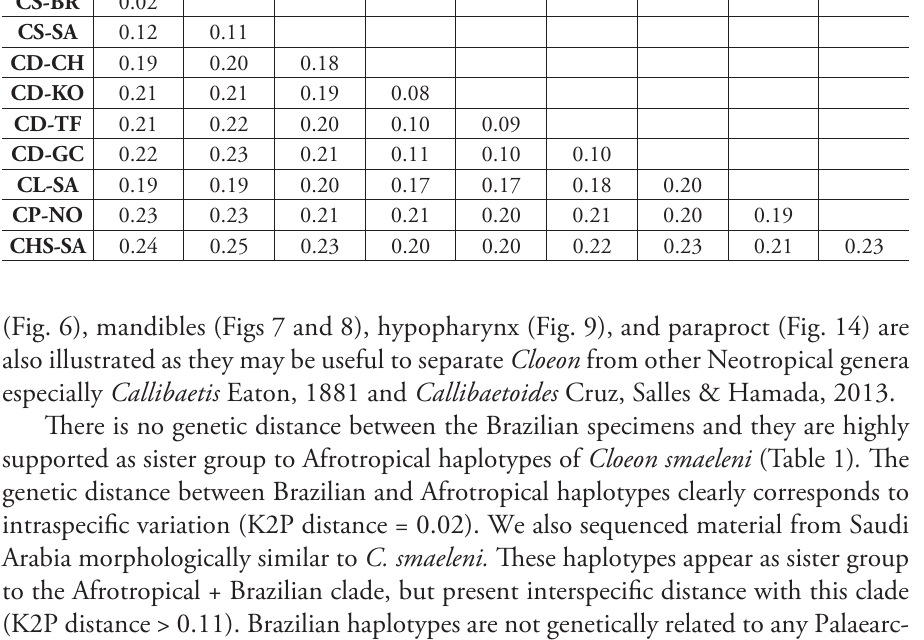
Table 1. Sequences using the Kimura 2-parameter: Taxa : CS = Cloeon smaeleni or Cloeon cf. smaeleni ; CD = Cloeon dipterum or Cloeon cf. dipterum ; CL: Cloeon sp1; CP = Cloeon praetextum ; CHS = Chele- ocloeon soldani. Countries : MA = Madagascar; BR = Brazil; SA = Saudi Arabia; CH = Switzerland; KO = South Korea; TF = Tenerife (Canari Islands); GC = Gran Canaria (Canari Islands); NO = Norway. CS-MA